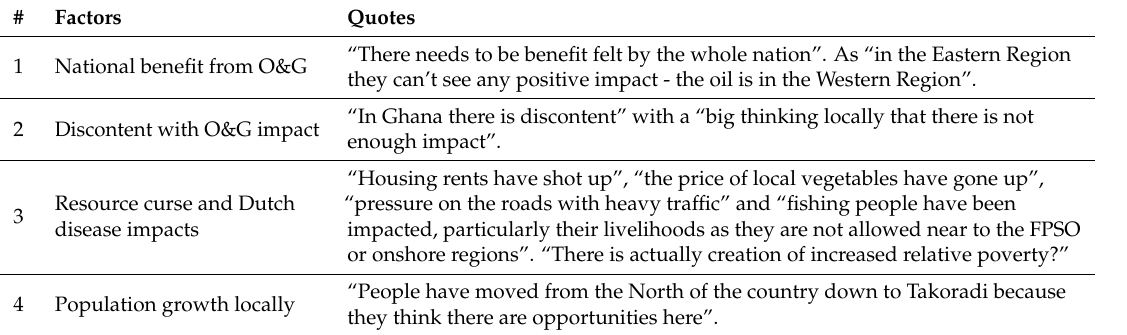
Table 14. ‘Impact of oil and gas in Ghana’ theme.